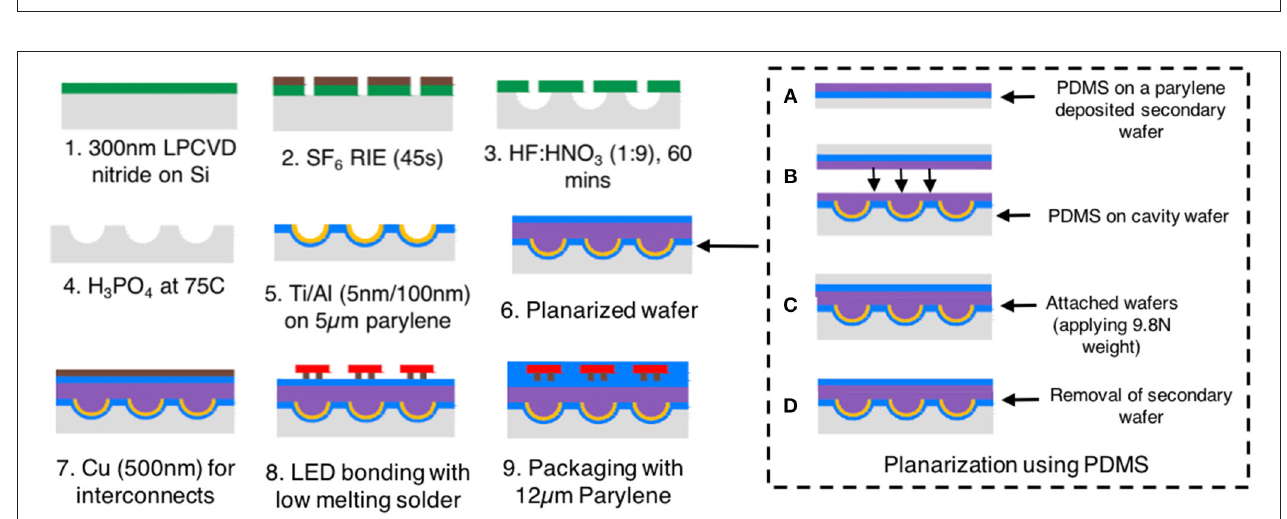
FIGURE 1 | Conceptual schematic of the reflector coupled µ -LED array stimulator.